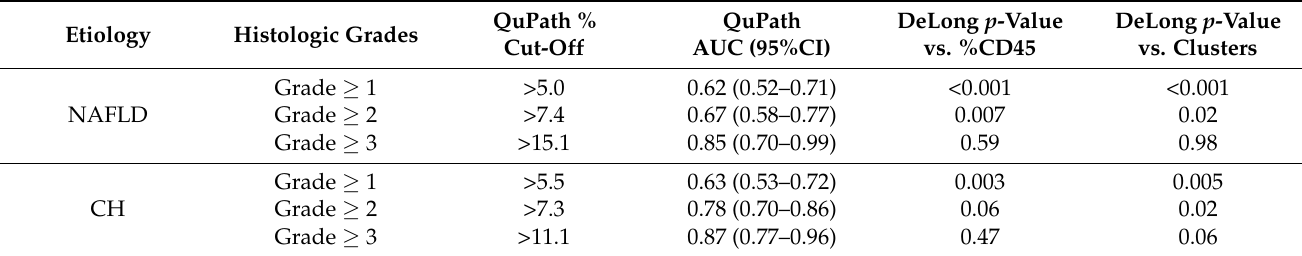
Table A1. Diagnostic performance of QuPath software for digital pathology image analysis: raw performance parameters for different histological grades and comparison with our MATLAB software